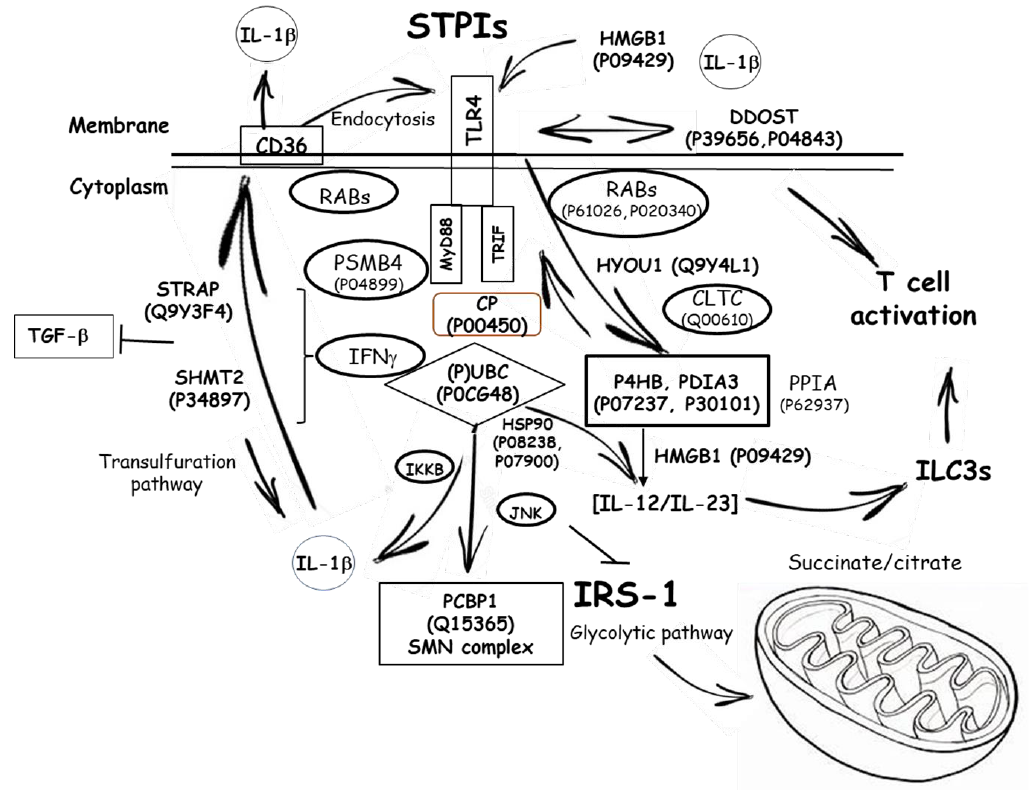
Figure 6. Proposed scheme of the interrelationship between the proteins with significant expression and the innate immune ‘Toll-like’ receptor (TLR)-4 during serine-type protease inhibitors stimulation of human-like macrophage cells. Abbreviations can be found in Table 1.